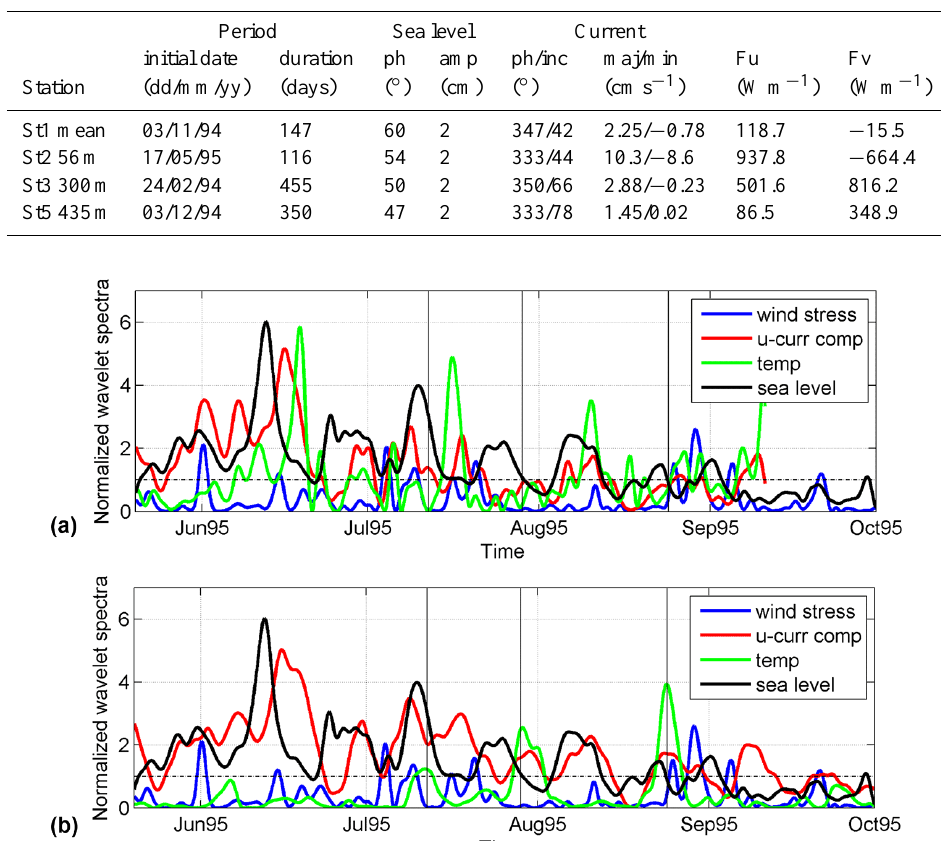
Fig. 13. Wavelet spectra of temperature, wind stress and u current component at station St2, and sea level at Otranto station, at the diurnal scale, for summer 1995. The spectra are normalized by the respective variance and significance levels. Black dashed line indicates 95% level of confidence. (a) upper current-meter (56m); (b) lower current-meter